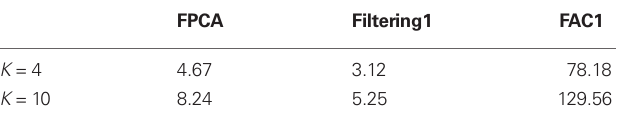
Table 2 | execution time in